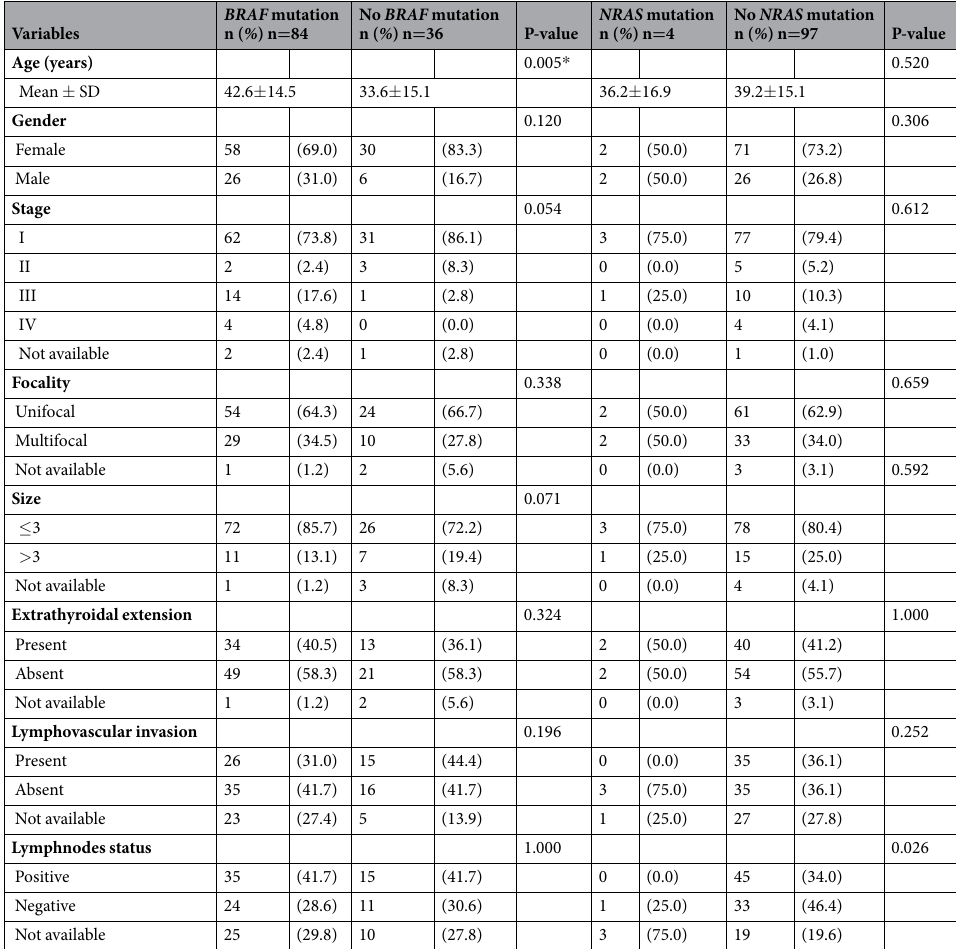
Table 2. Clinicopathological features of c-PTC cases with respect to BRAF and NRAS mutations. * Significant